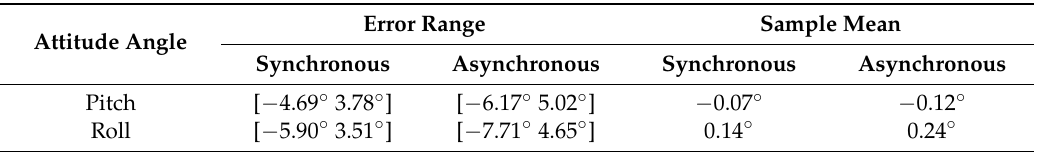
Table 2. Test error statistics.